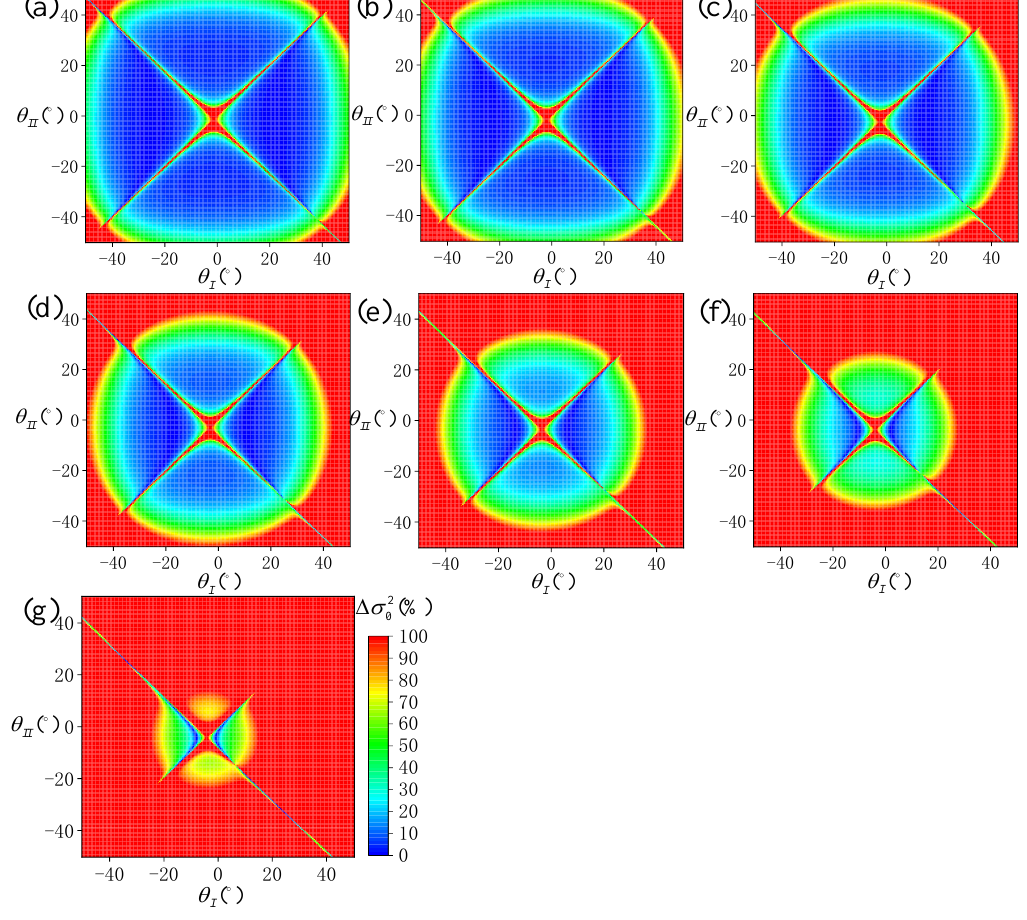
Figure 13. Distribution of SSR estimation error ( ∆𝜎 02 ) simulated under each SVA combination ( 𝜃 𝐼 , 𝜃 𝐼𝐼 ) at different sun zenith angles: ( a ) 𝜃 0 = 10°, ( b ) 𝜃 0 = 15°, ( c ) 𝜃 0 = 20°, ( d ) 𝜃 0 = 25°, ( e ) 𝜃 0 = 30°, ( f ) 𝜃 0 = 35° and ( g ) 𝜃 0 = 40°.